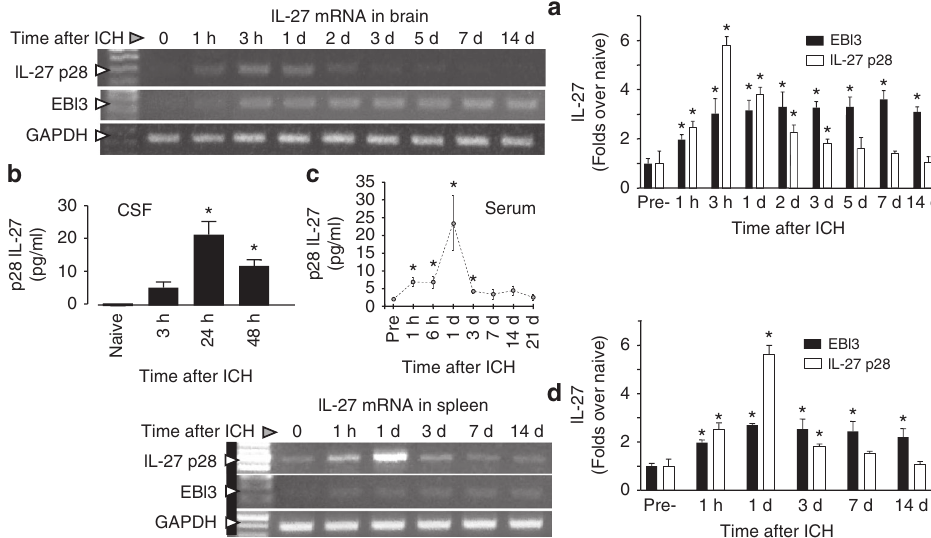
Fig. 1 Increased IL-27 production after ICH. a Photograph of representative gels demonstrating temporal changes of IL-27 p28 and EBI3 mRNA in the ICH-affected corpus striatum, at 0 h (sham control) and 1 h to 14 days after ICH in SD rats, which was assessed using RT-PCR, and ( a , right panel ) a bar graph of densitometrical quantitation. GAPDH was used as an internal control. The data were calculated as mean ± SEM ( n = 4). b Bar graph of IL-27 p28 protein levels in CSF in naïve rats and in rats at 3, 24, and 48 h after ICH. The data were calculated as mean ± SEM ( n = 3/time point). c Bar graph showing timecourse of IL-27 p28 protein levels in blood serum at 1 h to 21 days after ICH in C57BJ6 mice. The data were expressed as mean ± SEM ( n = 5). d Photograph of a representative gel demonstrating temporal changes in IL-27 p28 and EBI3 mRNA in the spleen of rats subjected to ICH, assessed using RT-PCR, and ( d , right panel ) a bar graph of densitometrical quantitation. GAPDH was used as an internal control. The data were calculated as mean ± SEM ( n = 4). * p ≤ 0.05, compared with the Sham group (0 h) for all the panels. The p -value in this fi gure was generated using one-way ANOVA followed